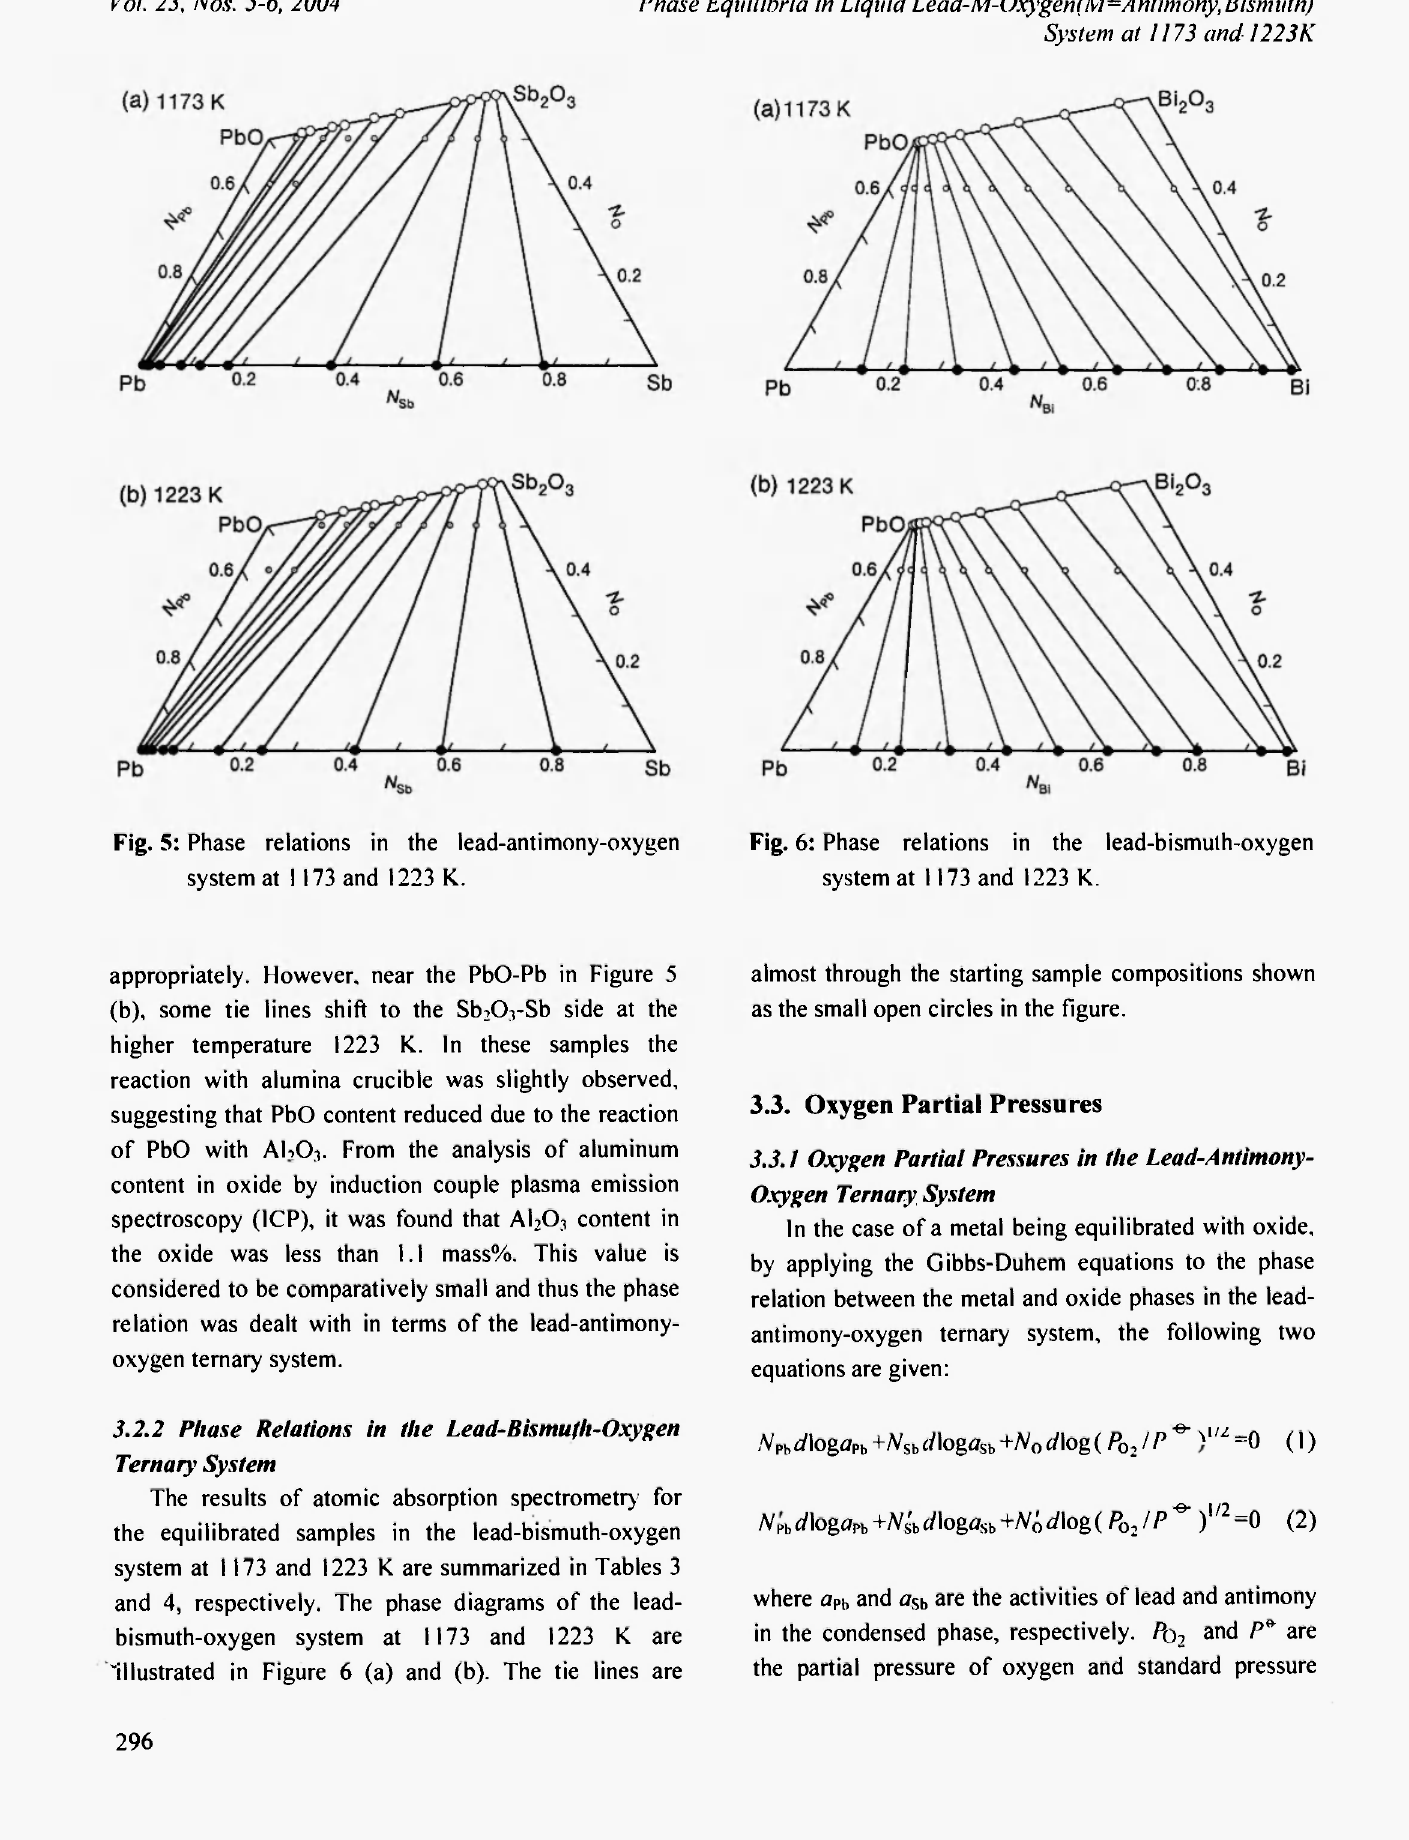
Fig. 5: Phase relations in the lead-antimony-oxygen system at 1173 and 1223 K.